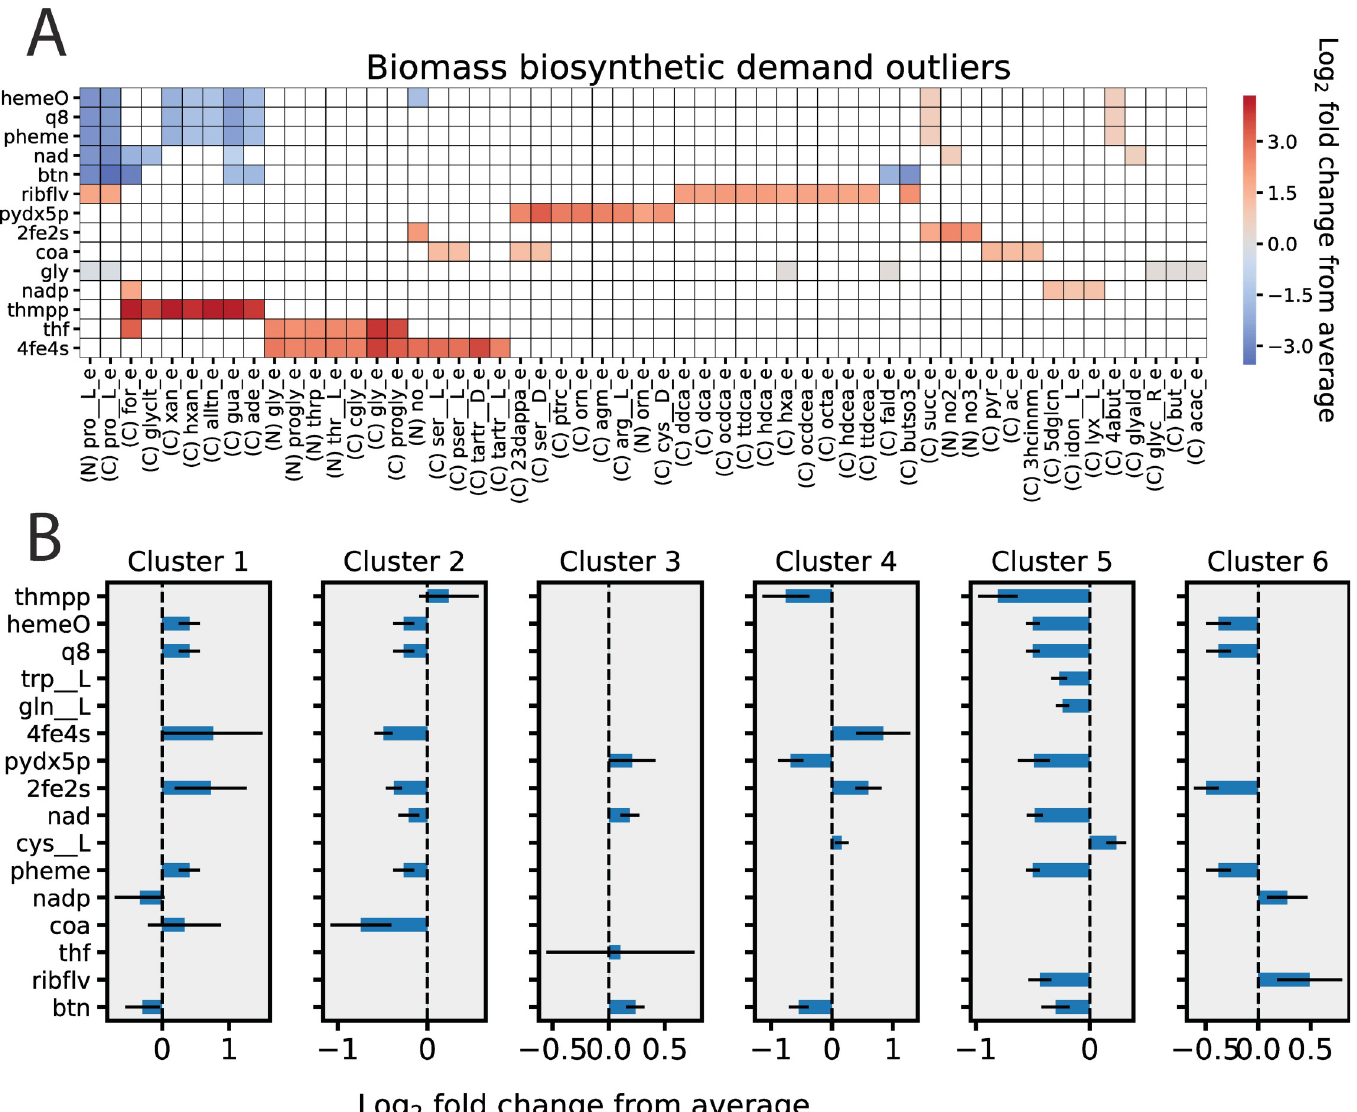
Fig 5. Characterization of aerobic condition-dependent biomass compositions. A) . Outlier analysis was performed to find growth conditions with z-scored biomass constituent synthesis demands with absolute values greater than 3. The colors on the heatmap denote the log 2 fold change of the outlier compared to the average biosynthetic demand of all aerobic growth conditions. B) Hierarchical clustering using Ward’s linkage was performed to divide the in silico growth conditions into 6 clusters based on their predicted biomass demands. All 6 clusters contained multiple biomass demand values that were statistically different (p < 1x10 -5 by Wilcoxon rank- sum test and log 2 fold change > 0.15) compared to the non-cluster demands. The significant log 2 fold changes are shown comparing growth conditions in each cluster compared to the average for growth conditions not in the cluster. Error bars represent the standard deviation of the log 2 fold change